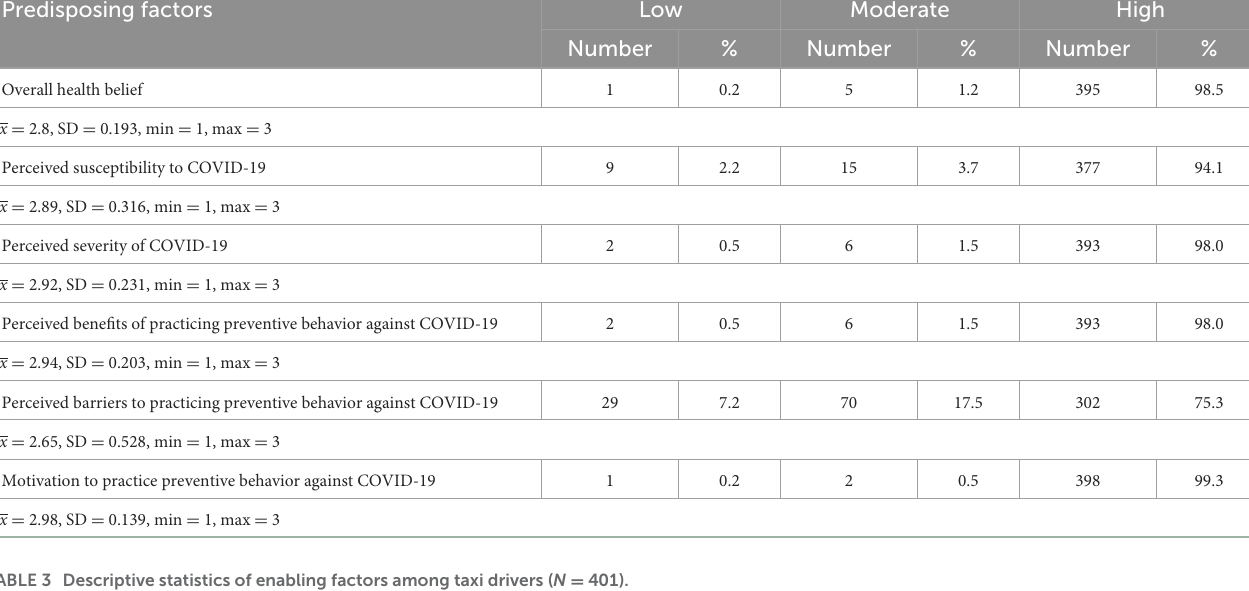
TABLE 3 Descriptive statistics of enabling factors among taxi drivers ( N = 401).